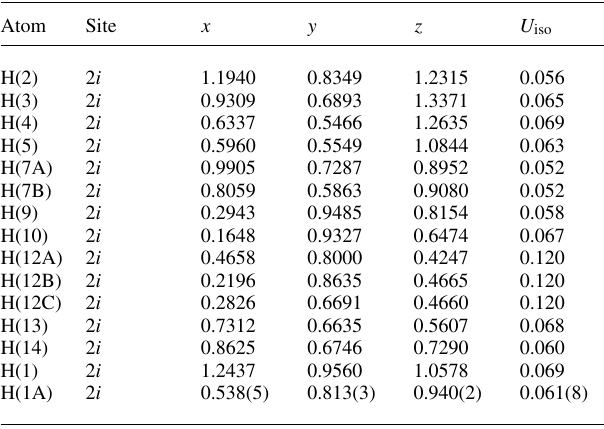
Table 2. Atomic coordinates and displacement parameters (in Å 2 ) .